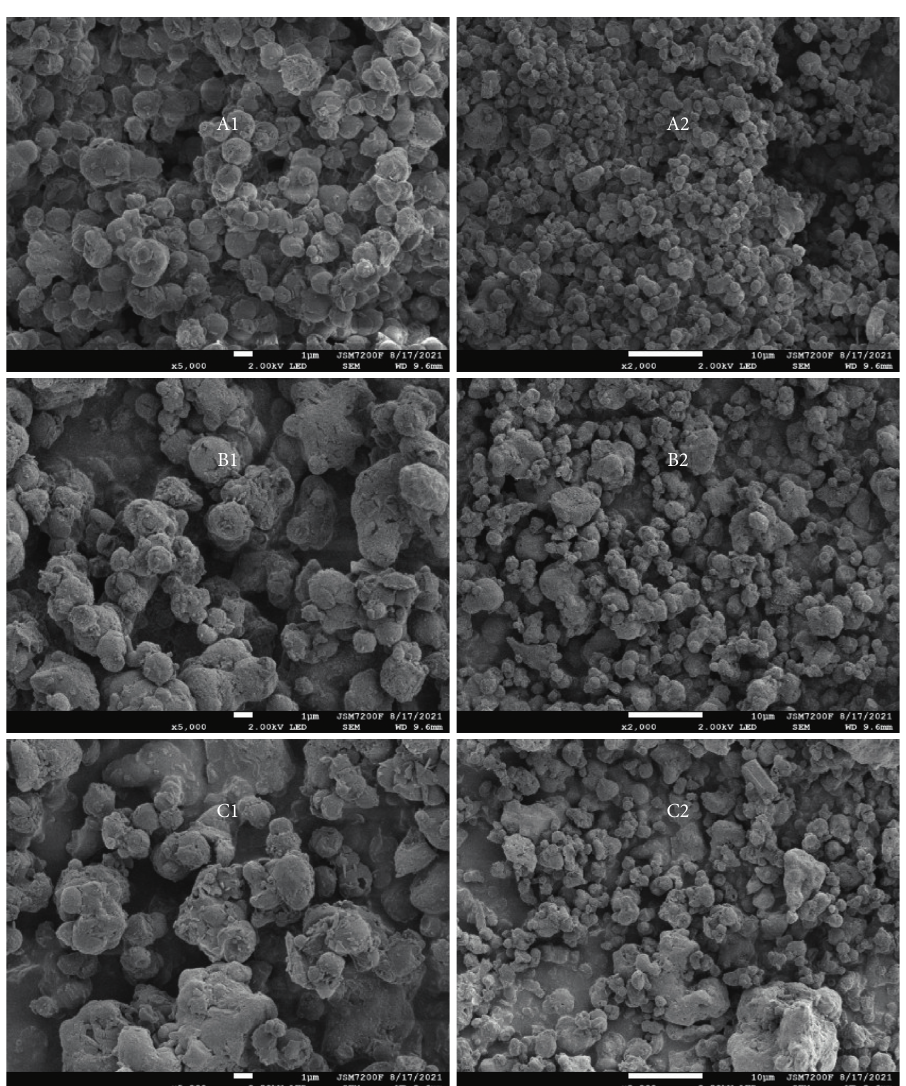
Figure 8: SEM images of the sample A (A1, A2), sample B (B1, B2), and sample C (C1, C2) (5000x (left) and 2000x (right),